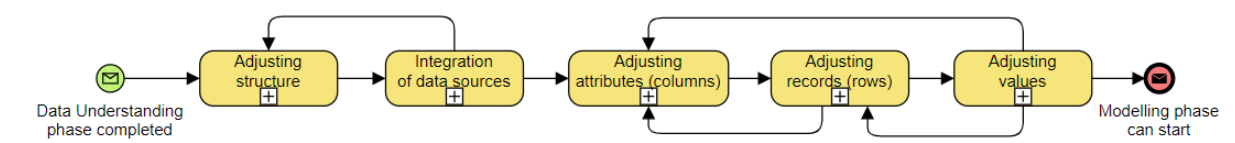
Figure 1. Top diagram proposal for the ‘Data Preparation’ phase.